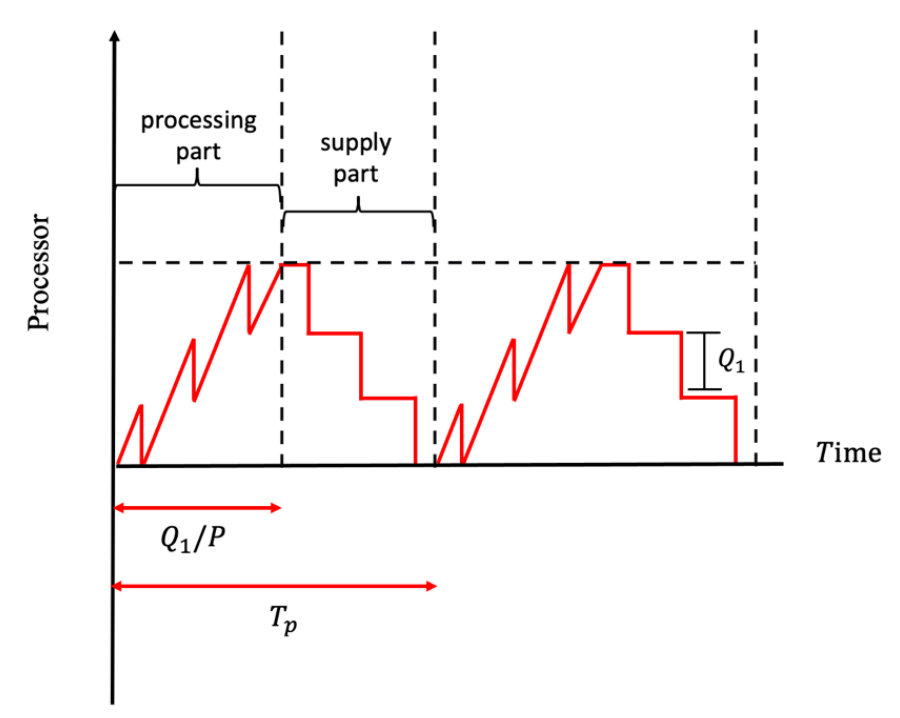
Figure 5. Processor’s inventory